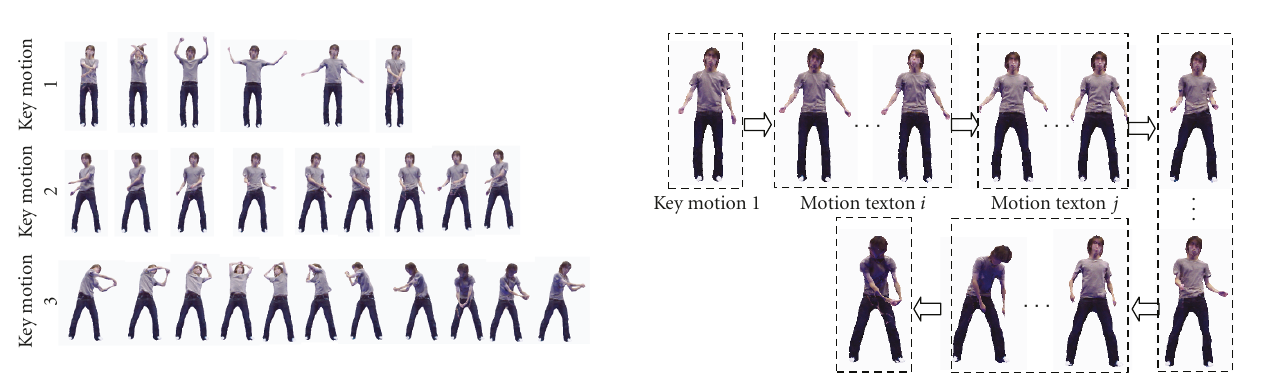
Figure 9: Transitions (denoted by arrows) in two best